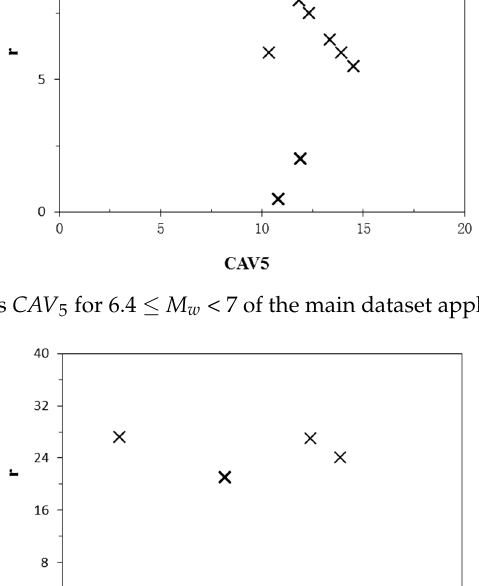
Figure 5. r versus CAV 5 for 7 (cid:3409) M w (cid:3409) 7.9 of the main dataset applied in this study.